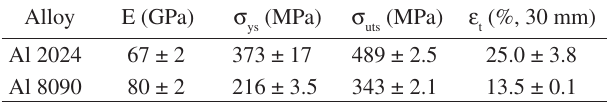
Table 1. Tensile properties of 2024 and 8090 aluminum alloys. Three speci- mens.